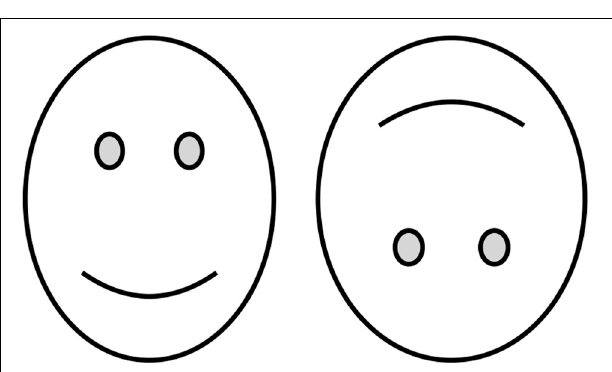
FIGURE 2 | Schematic illustration of typical stimulus shown to observer on a single trial. The observer has to choose the face that looks wider. The stimulus in the experiment used was a picture of the actor James Corden’s face, with all background details removed (see http://illusionoftheyear.com/2010/the-fat-face-thin-fft-illusion).